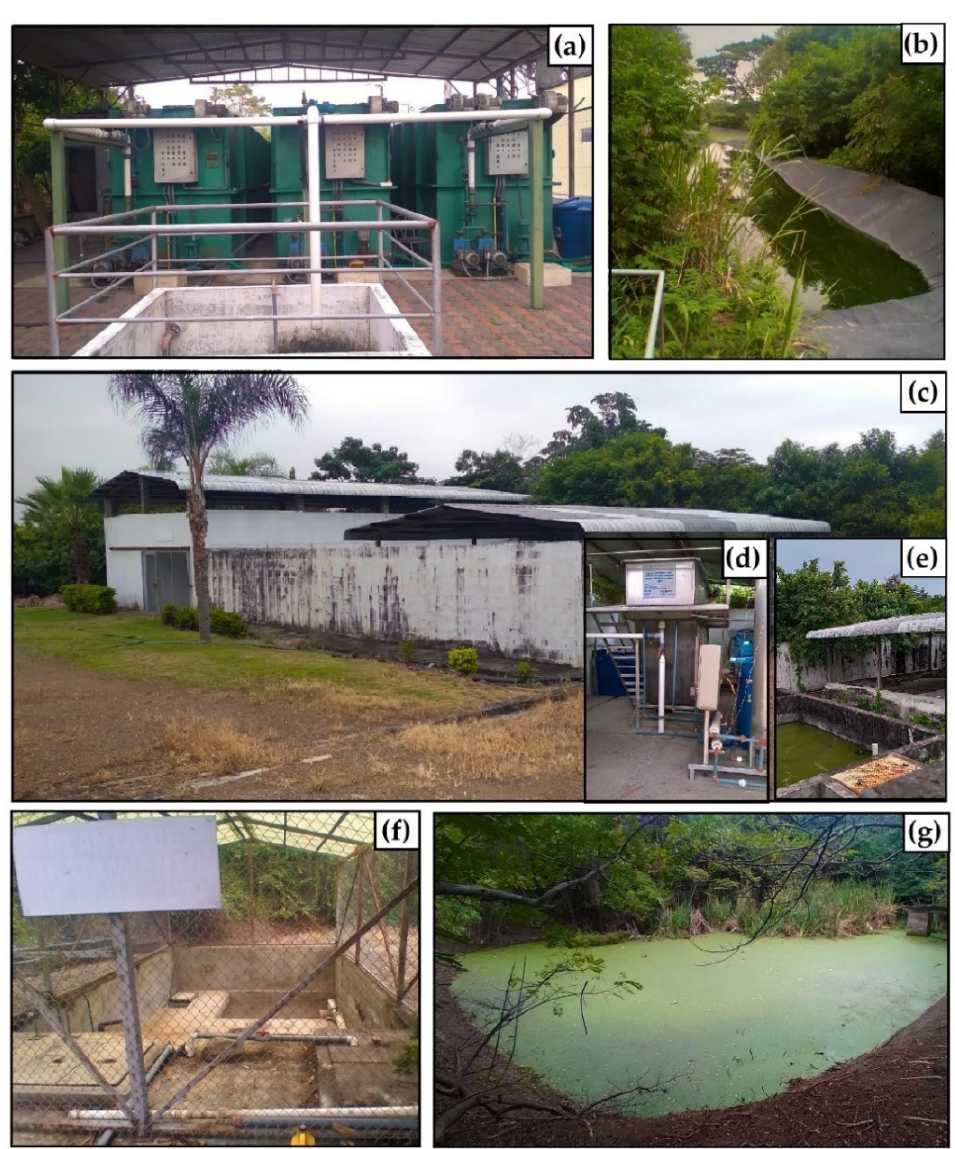
Figure 9. Existing on-campus wastewater treatment systems. ( a ) Membrane biological reactor wastewater treatment plant (WWTP-MBR), ( b ) engineering area stabilisation pond, ( c – e ) dissolved air flotation system (WWTP-DAF), ( f ) activated sludge wastewater treatment plant, ( g ) technology